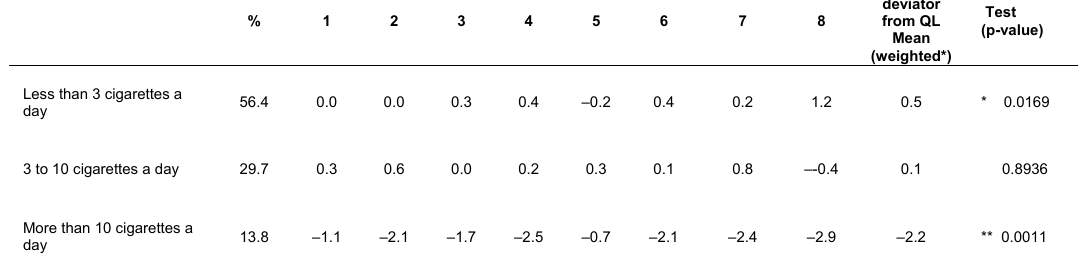
Percentage Deviation from the Mean Quality of Life Expressed as a Percentage of That